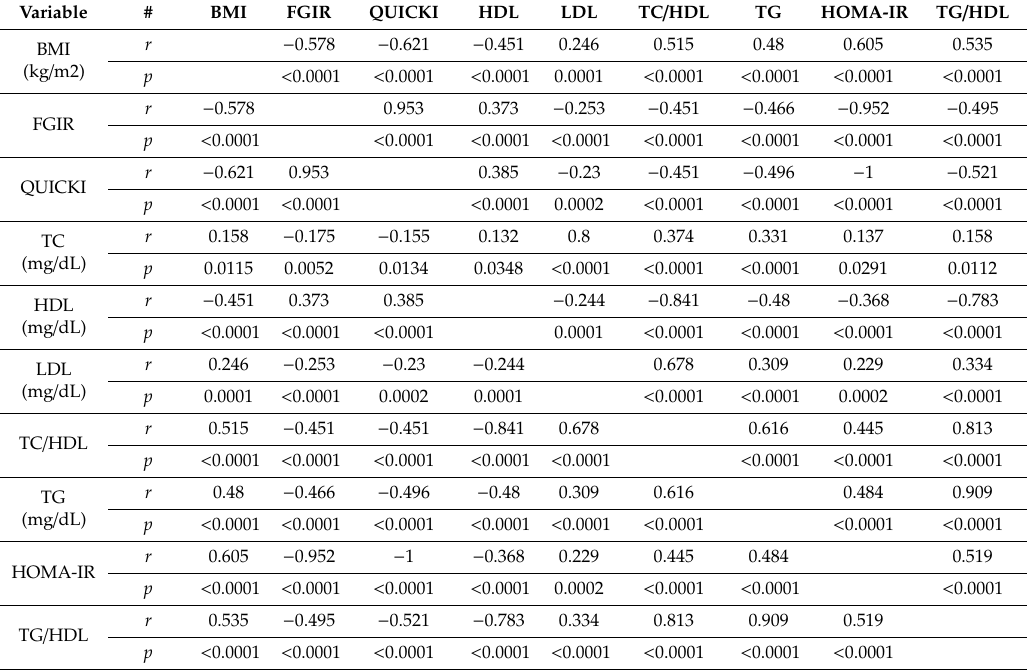
Table 5. Correlation between studied parameters in Group 2.